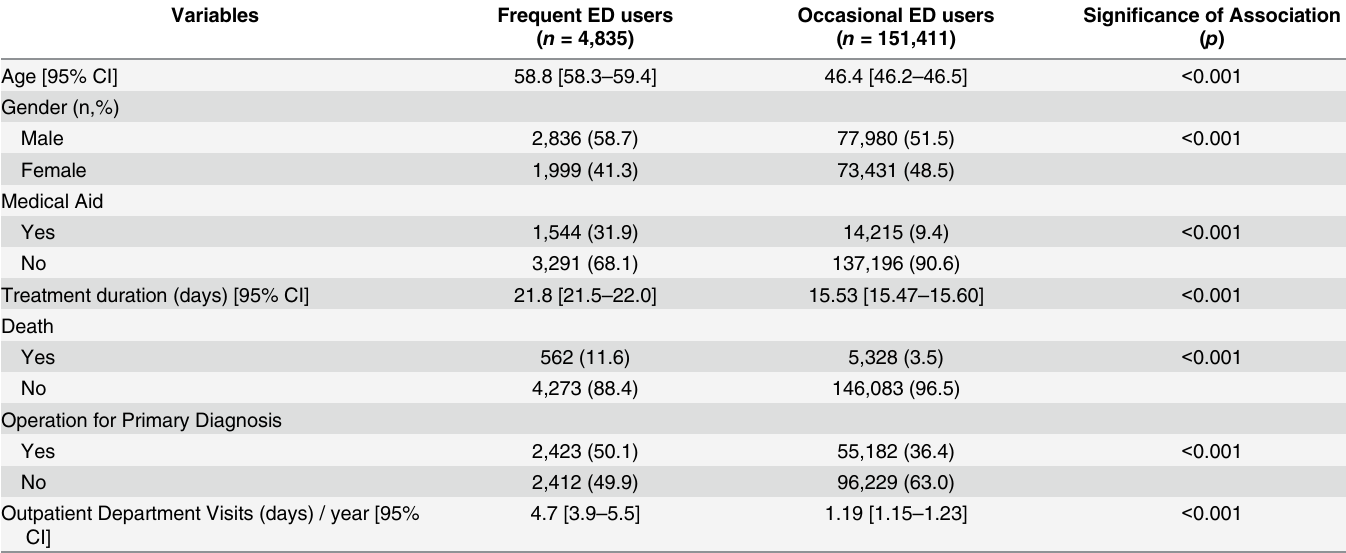
Table 1. Characteristics of frequent and occasional ED users.